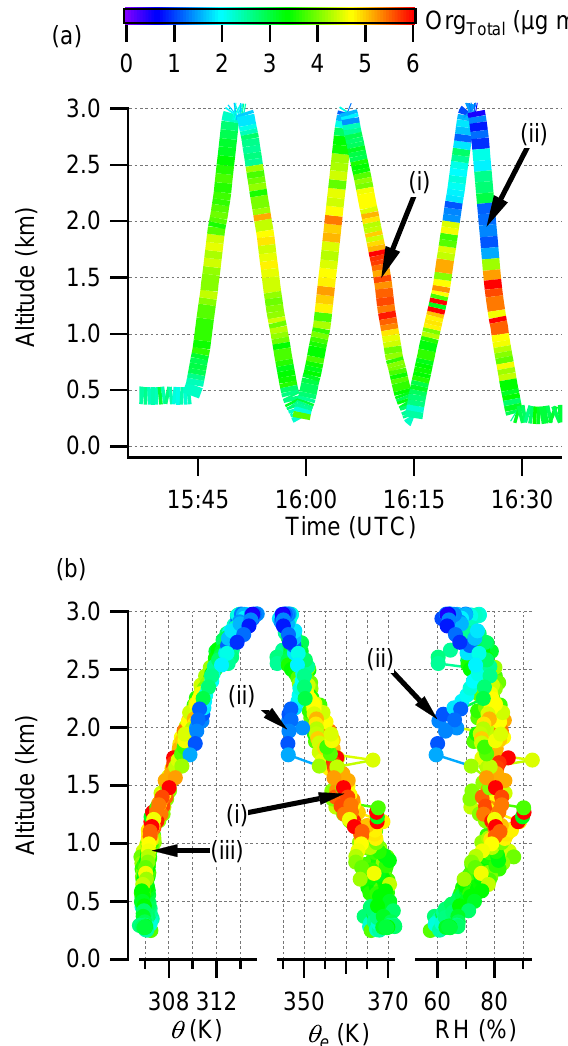
Figure 3. Profile data of potential temperature ( θ) , equivalent po- tential temperature ( θ e ) and relative humidity (RH) from the B749 “sawtooth” manoeuvre, coloured according to organic mass con- centration. Highlighted are the (i) peak in organic concentration, (ii) layer of low mass concentration and humidity and (iii) top of the well-mixed boundary layer, as evidenced by θ